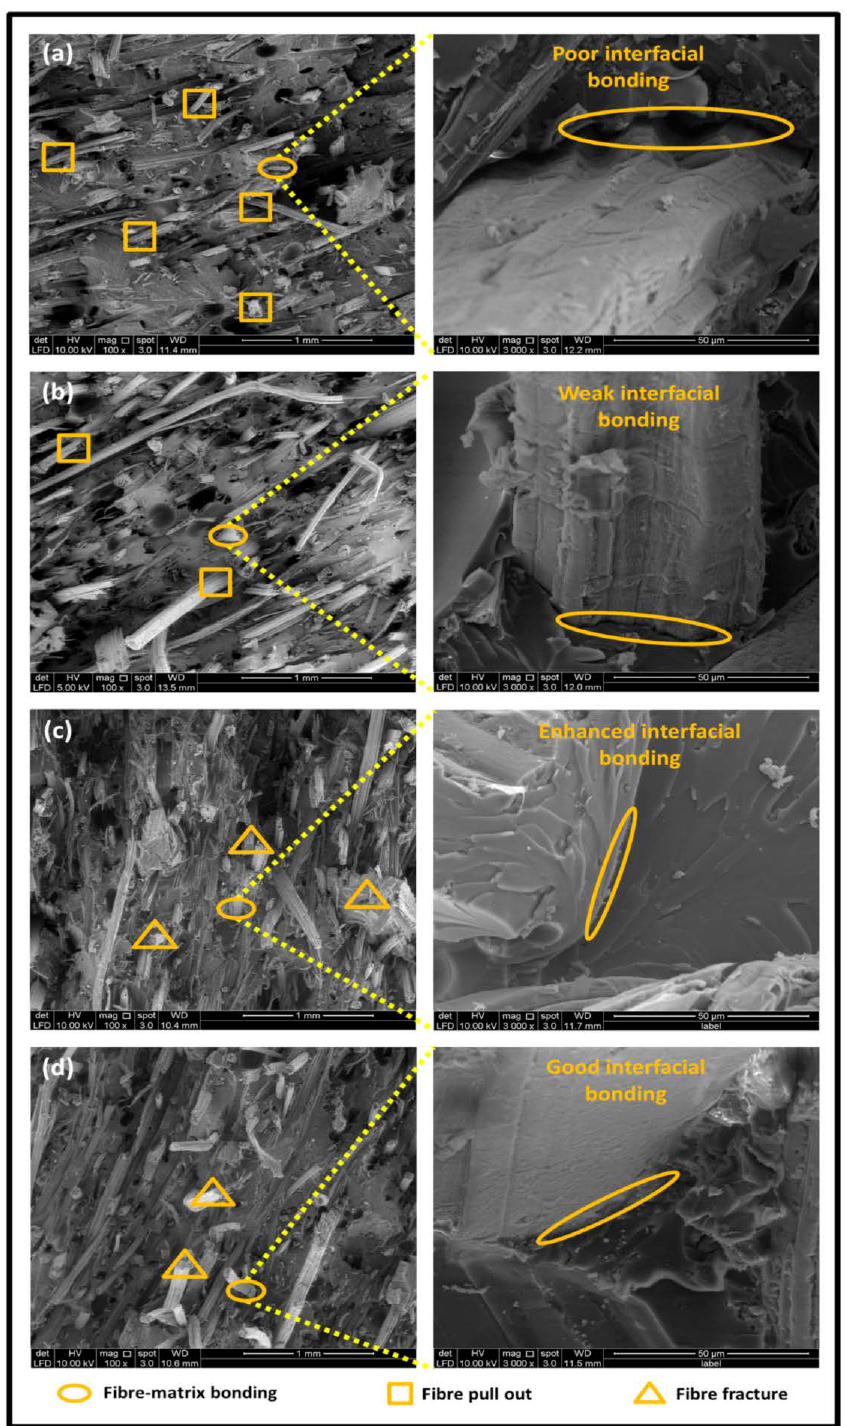
Figure 6. FESEM micrograph of the tensile fracture surface of ( a ) VE/K/NC0, ( b ) VE/K/NC1, ( c ) VE/K/NC3, and ( d )